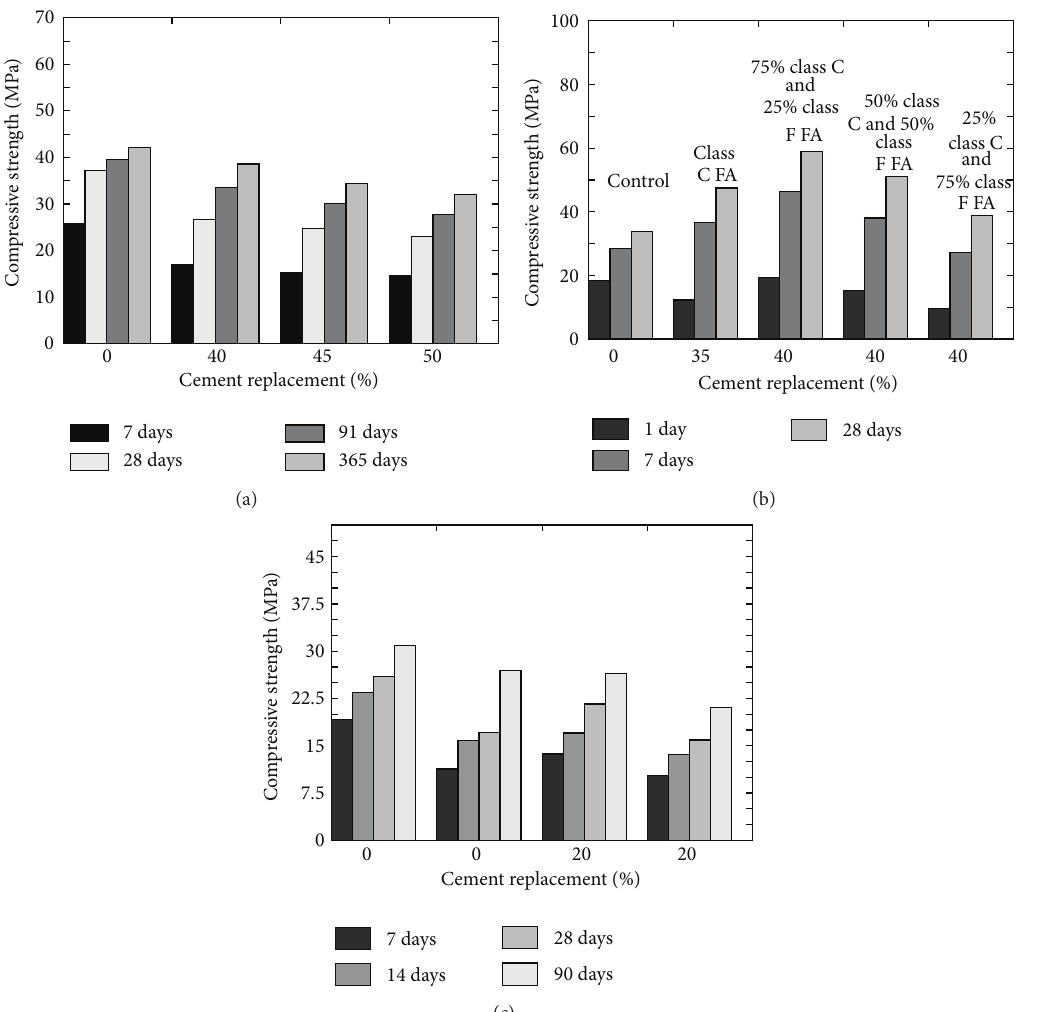
Figure 8: (a) Effect of cement replacement (w / b ≈ 0.4 ) [36], (b) FA types [26], and (c) water binder ratio (w / b = 0.48 and 0.5) [25] on the compressive strength of FA